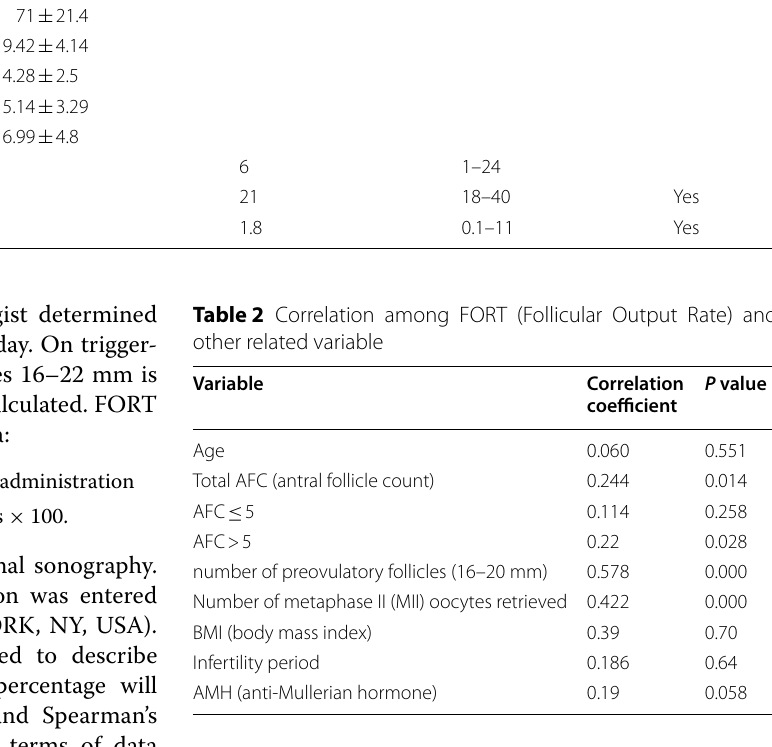
Table 3 Multiple linear regression analysis among